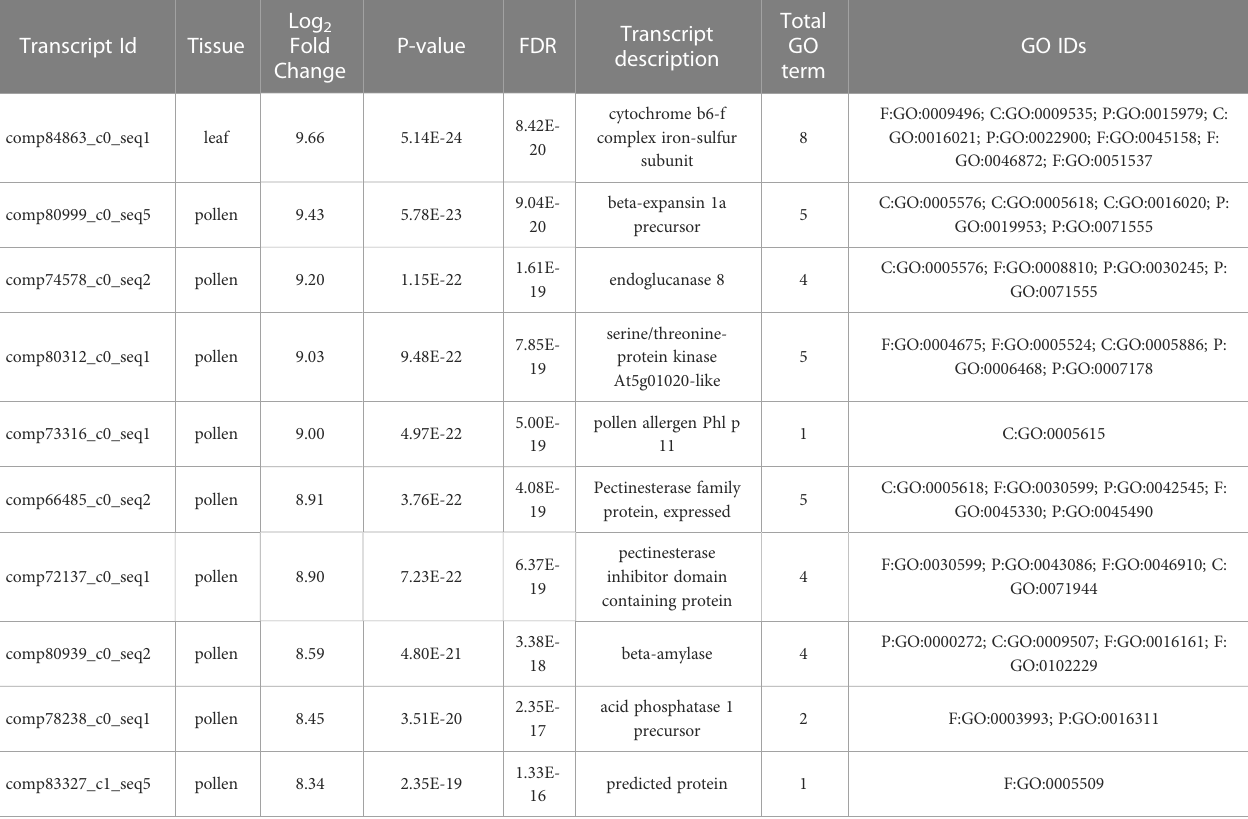
TABLE 2 Top 10 up-regulated DEGs in leaf, pollen, and ovule in comparisons of LM 11 (S) and CML 25 (T) inbreds under heat stress conditions.